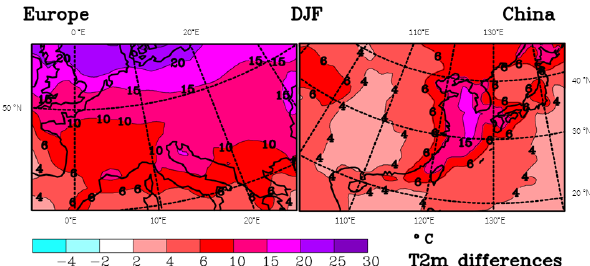
Figure 2. Difference maps between simulated CTR and LGM T2m during winter (DJF) for Europe and eastern